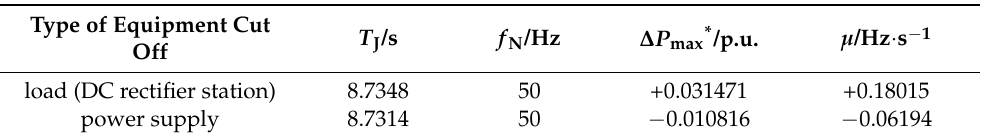
Table 6. The maximum rate of change of frequency after a single piece of equipment is suddenly cut off in Qujing Power